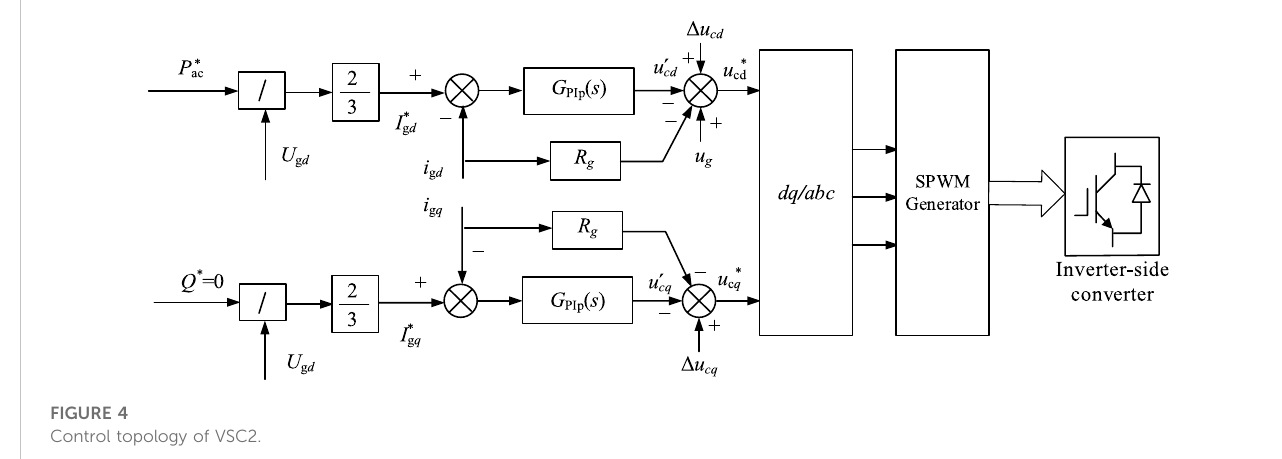
FIGURE 4 Control topology of VSC2.